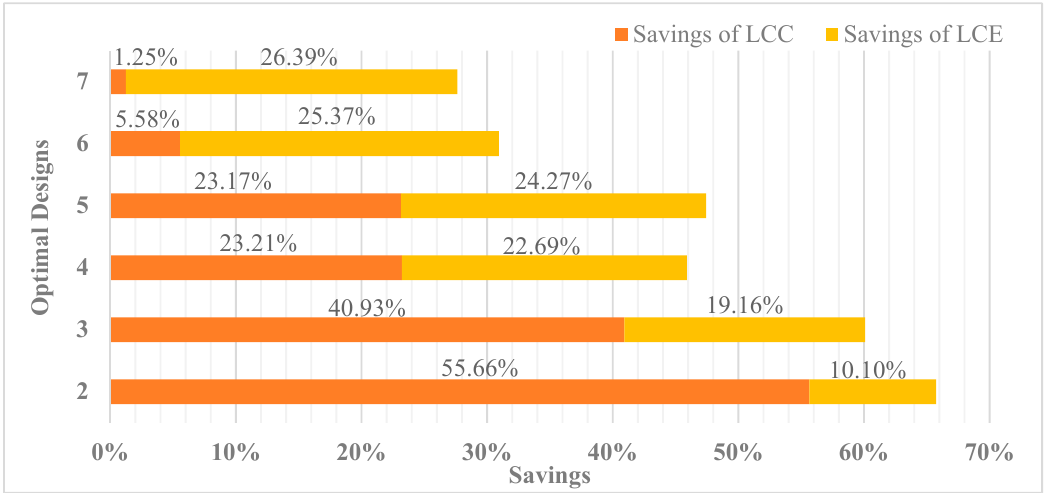
Figure 4. Life cycle cost (LCC) and life cycle energy (LCE) savings from the optimal designs compared with the initial design.